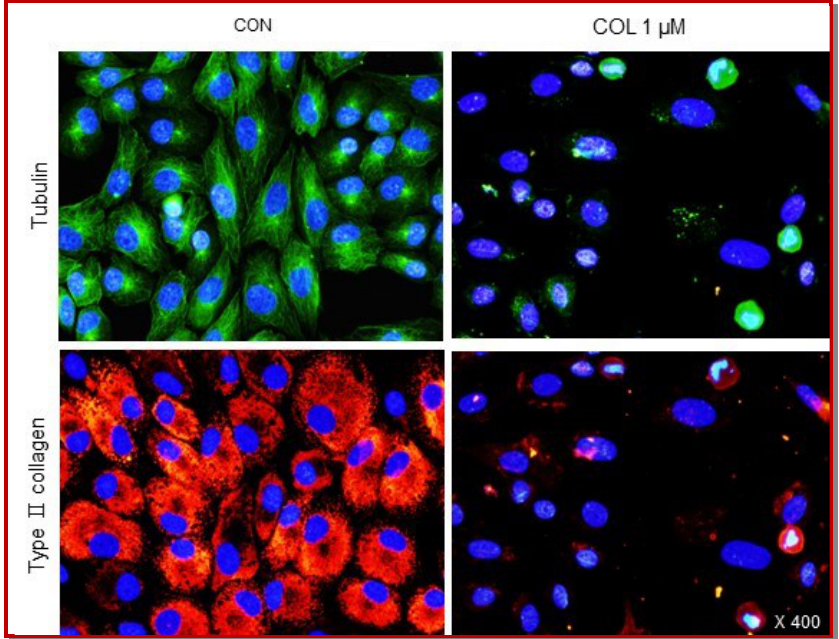
Figure 2: In rabbit articular chondrocytes, colchicine decreases tubulin production and chondrocyte differentiation. For 24 hours, chondrocytes were either left untreated or given 1 mM colchicine. Using immunofluorescence staining, it was possible to measure the expression of type II collagen and tubulin. Cells were labelled with a particular antibody (red or green) and DAPI for nuclear staining (blue). Magnification